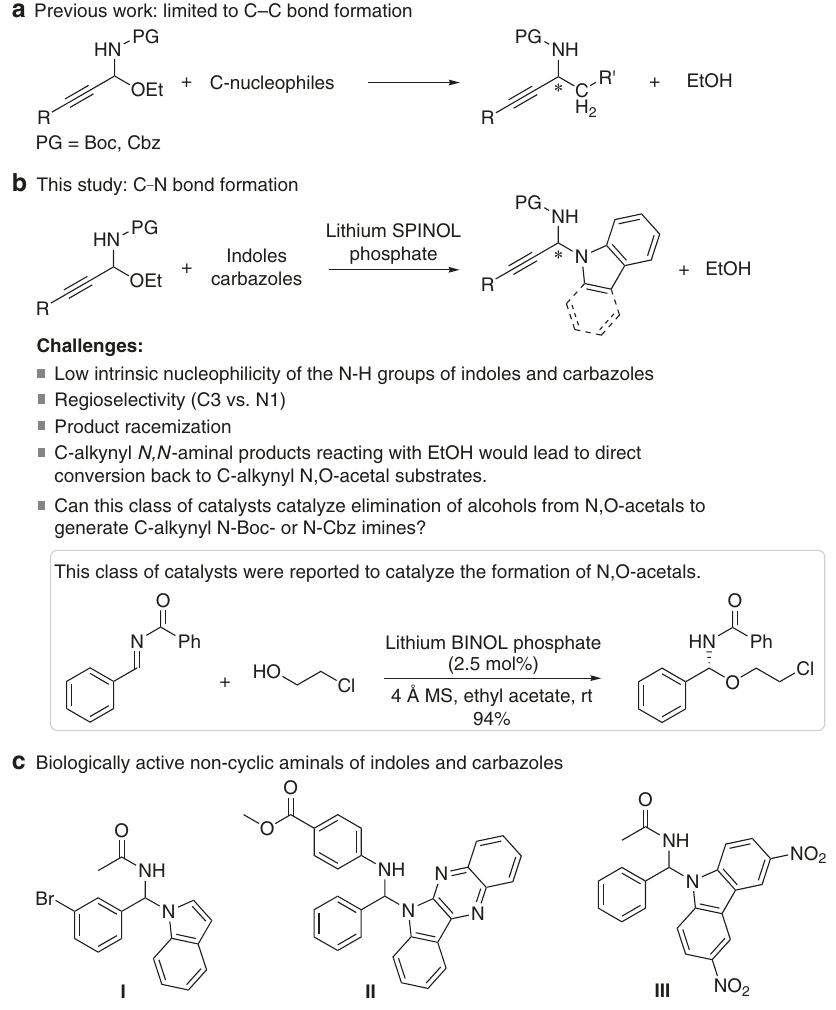
Fig. 2 Asymmetric reactions of C-alkynyl N,O-acetals with nucleophiles. a C-based nucleophiles. b 1H-Indoles and carbazoles as N-based nucleophiles (several challenges are shown). c Non-cyclic aminals of indoles and carbazoles as antibiotics. Boc, t -butyloxy carbonyl, Cbz benzyloxycarbonyl, PG protecting